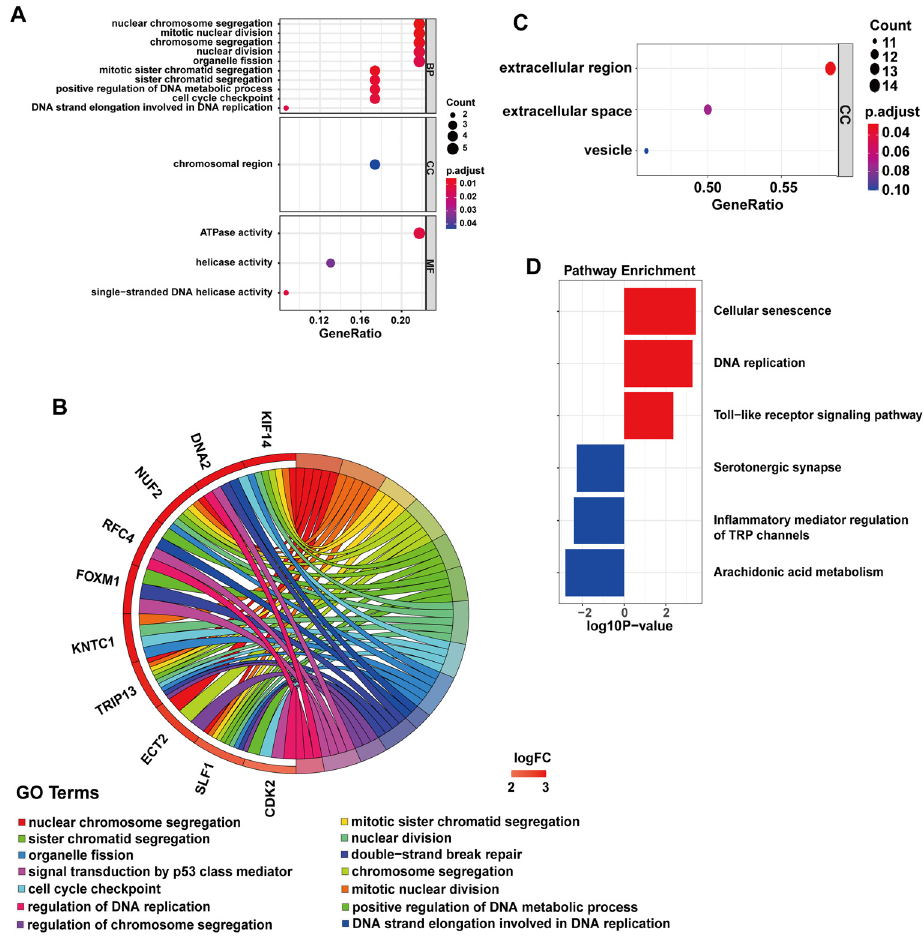
Figure 4. Functional annotation for coexpressed differentially expressed genes (DEGs). A , Gene Ontology (GO) analysis of the 23 shared upregulated genes, including biological process (BP), cellular component (CC), and molecular function (MF). B , Genes linked by ribbons to their enriched terms are presented in the GOChord plot. C , GO analysis results are shown of the 30 shared downregulated genes in the cellular component only (CC). D , KEGG pathway enrichment analysis results of the 53 shared genes are shown. P o 0.05 ( t